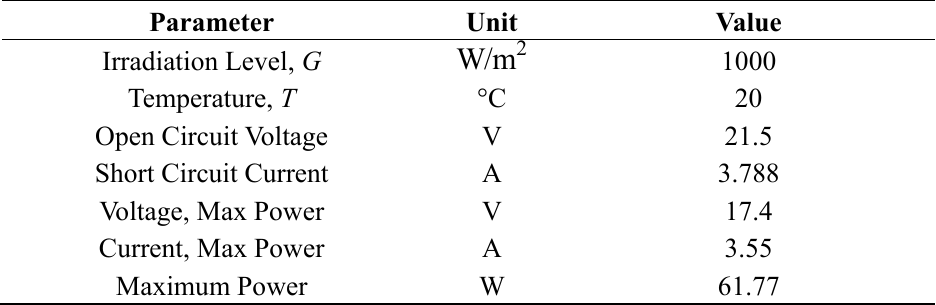
Table 1. Characteristics of the Solarex MSX 60 PV panel operate at 20